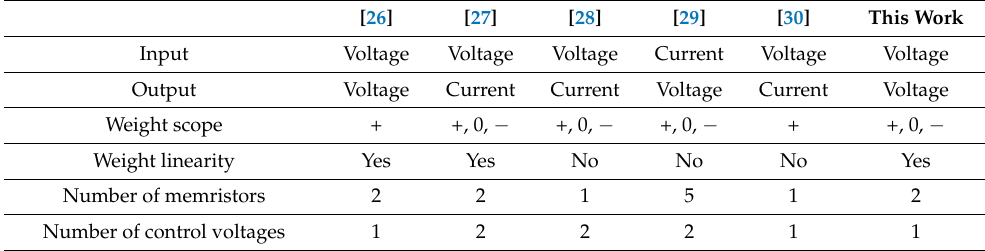
Table 2. Comparison of memristive synaptic circuits.